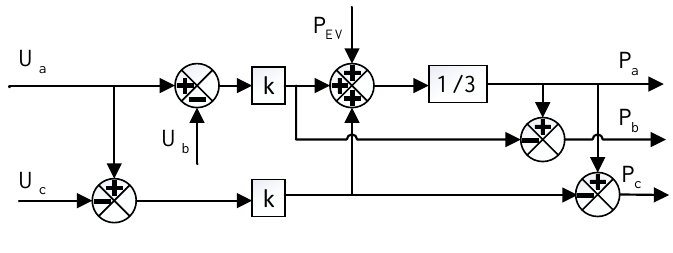
Figure 7. Load balancing control block diagram.